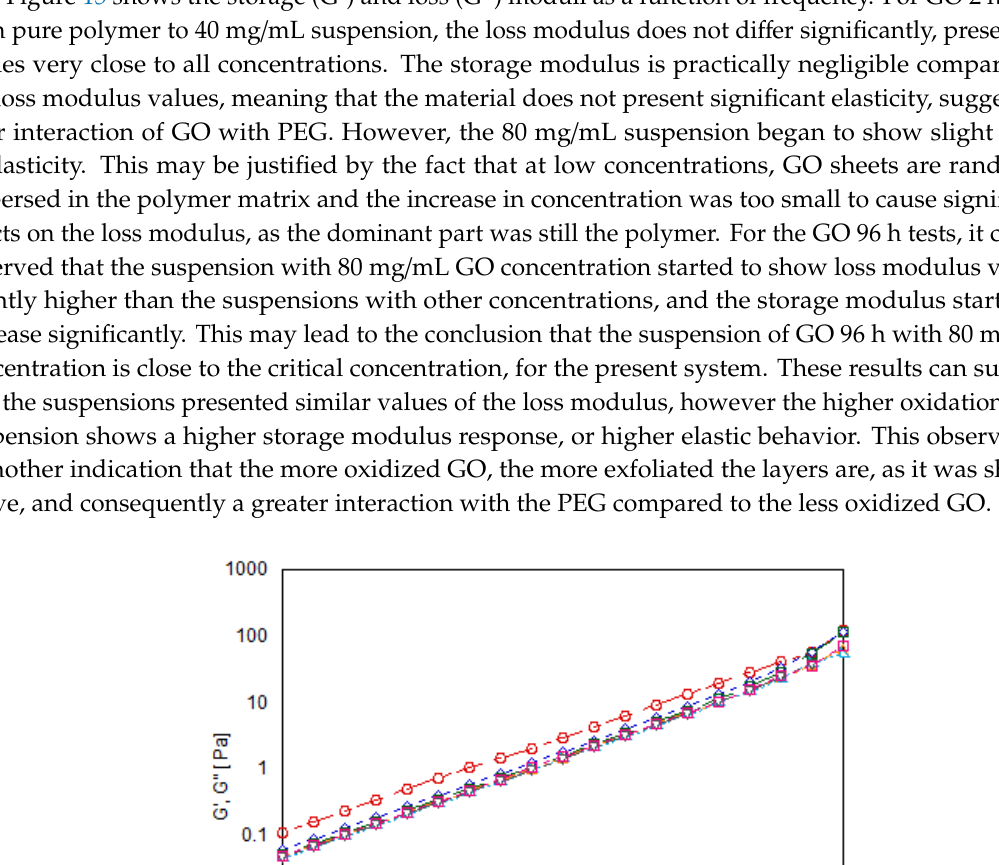
Figure 15. Frequency Sweep of the loss (open symbols) and storage (filled symbols) modulus for suspensions of ( a ) GO of 2 h ( b ) GO of 96 h of oxidation with different concentrations: ● red—80 mg/mL, ♦ dark blue—40 mg/mL, ■ green—20 mg/mL, ▲ orange—10 mg/mL, ► light blue—1 mg/mL, ▼ grey—0.1 mg/mL and ■ pink—0 mg/mL. 4. Conclusions This work presented a rheological characterization of suspensions of graphene oxide (GO) nanosheets in polyethylene glycol (PEG). The effect of oxidation time and concentration were investigated. The GO characterization techniques showed that the oxidation occurred and that the longer the oxidation time, the greater the number of functional groups introduced in the graphite structure, increasing interplanar distances. This improves the process of exfoliation, resulting in